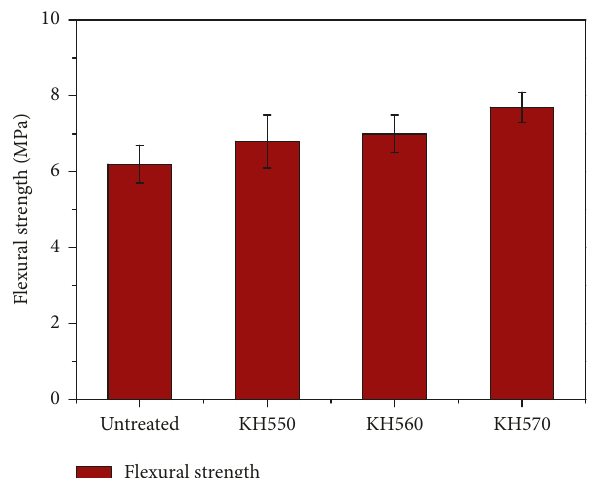
Figure 4: Flexural strength of TPR cement slurry modified by different silane coupling agents.